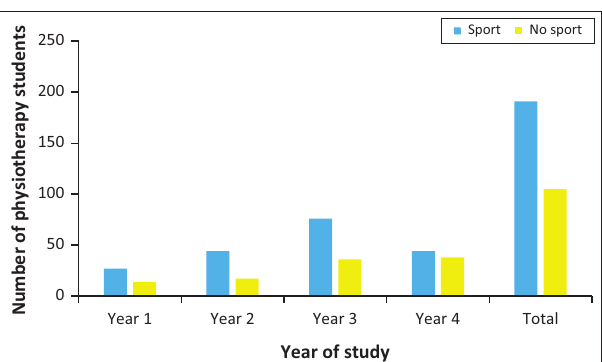
FIGURE 1: Number of physiotherapy students reporting participating in sporting activities on a weekly basis ( n = 296).